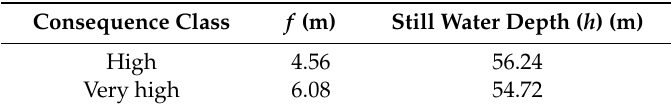
Table 3. Consequence class with freeboard values and the corresponding still water depth used in the experimental setup for a fixed dam height H = 60.8 m (prototype scale).